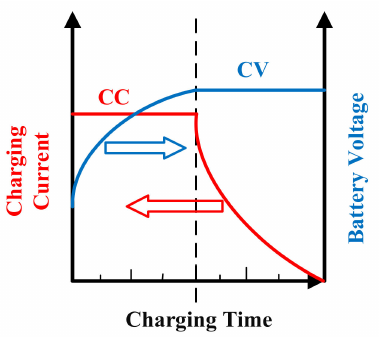
Figure 2. Constant-current–constant-voltage charging of a lithium-ion battery